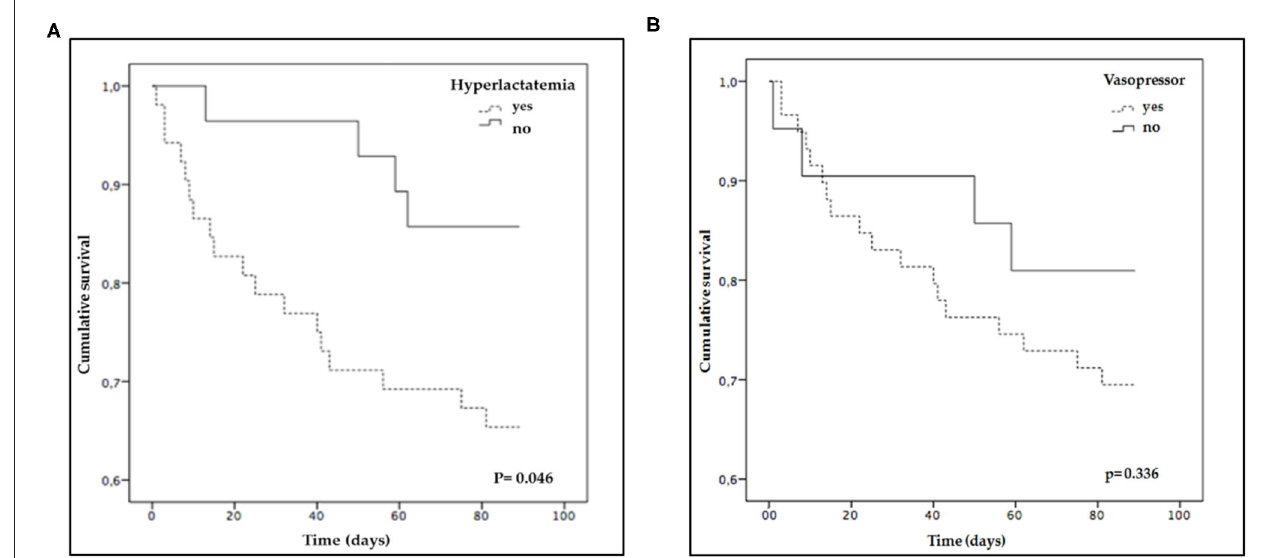
FIGURE 1 | Survival curves of oncological patients. The curves comparison was performed using Log-Rank test: (A) Categorized according to hyperlactatemia ( > 2 mmol/L); (B) Categorized according to vasopressor need.